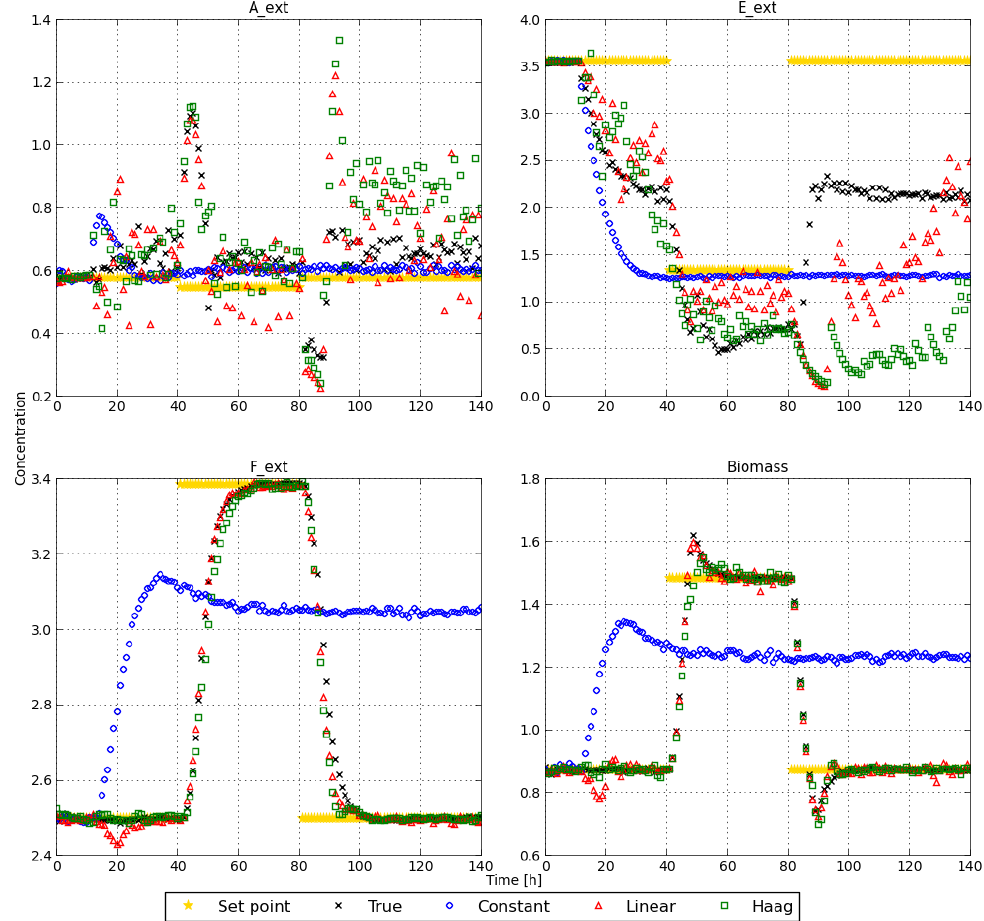
Figure 7. Concentrations and set points for the different extracellular metabolites, obtained with the different flux models.